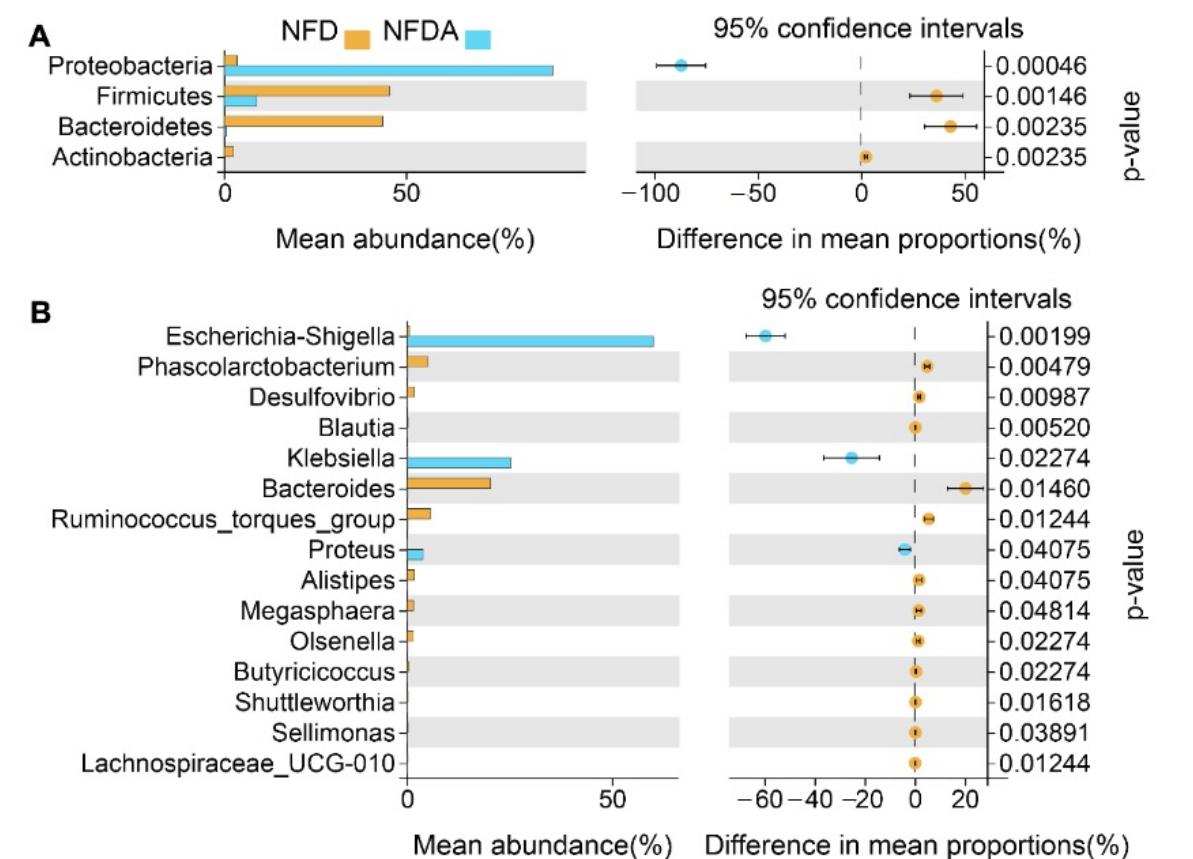
Figure 3. Differential taxa (phyla and genera) between control ( n = 5) and antibiotic treatment ( n = 5) groups. ( A ) Differential phyla. ( B ) Differential genera. p < 0.05 indicates significant difference. NFD ( n = 5), NFDA ( n =